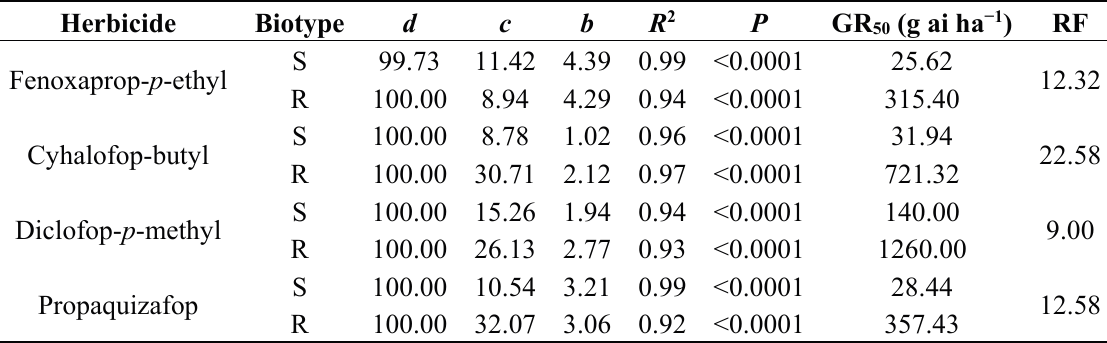
Table 1. Parameters of the log-logistic equation a used to calculate the herbicide dose required for 50% reduction of the fresh weight (GR 50 ) of R and S biotypes of P. minor